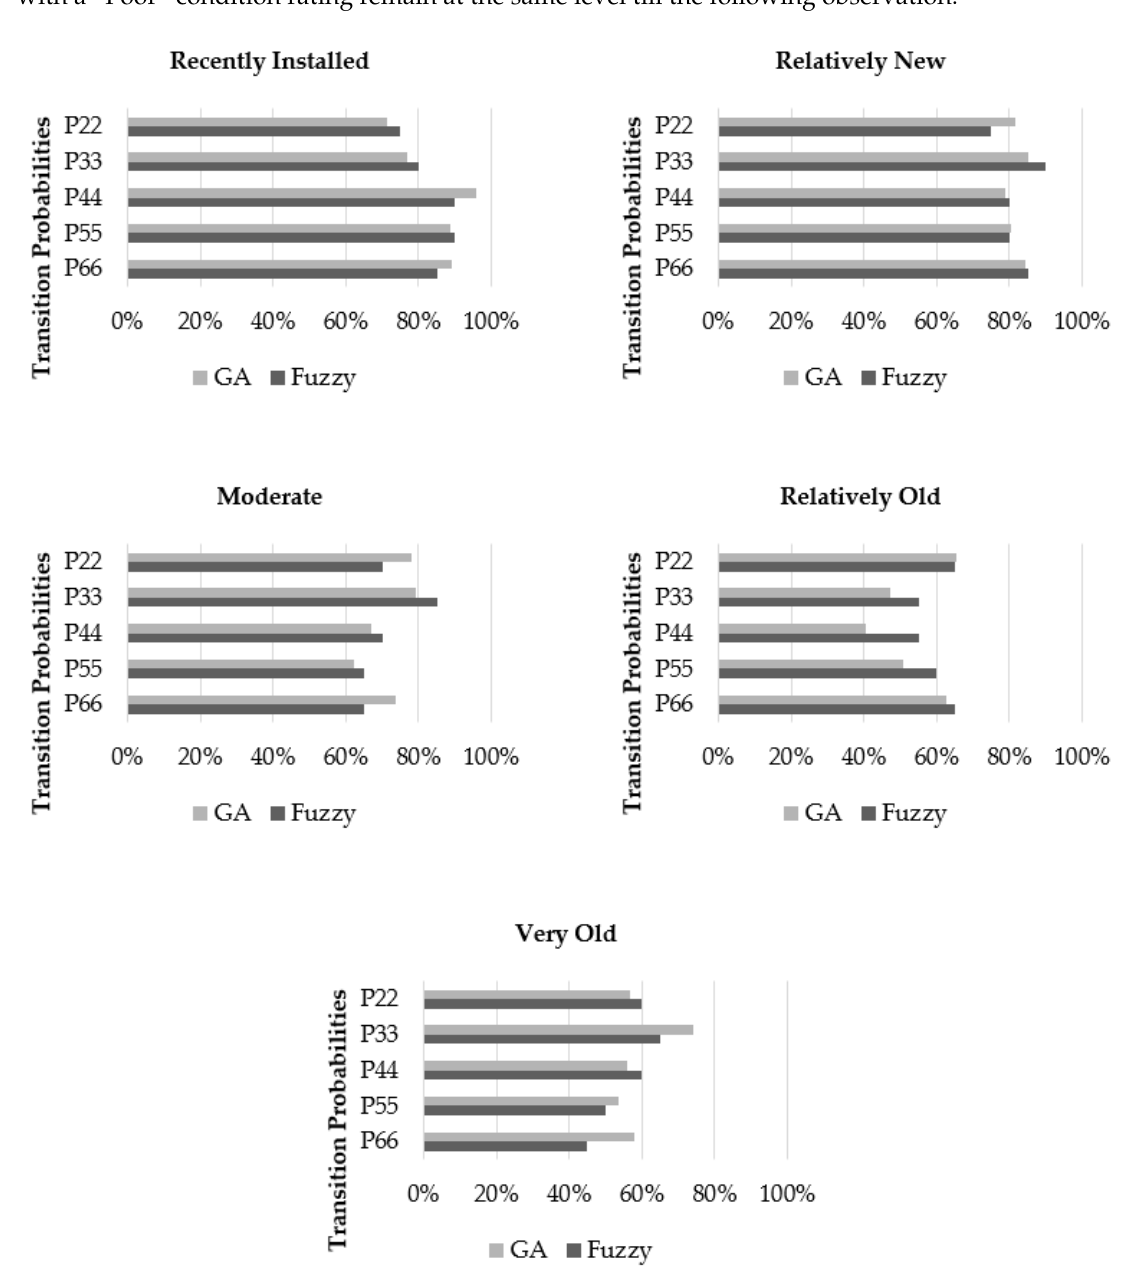
Figure 10. Fuzzy-based (initial) and optimum GA-derived (modified) transition probabilities for each zone in system’s life.